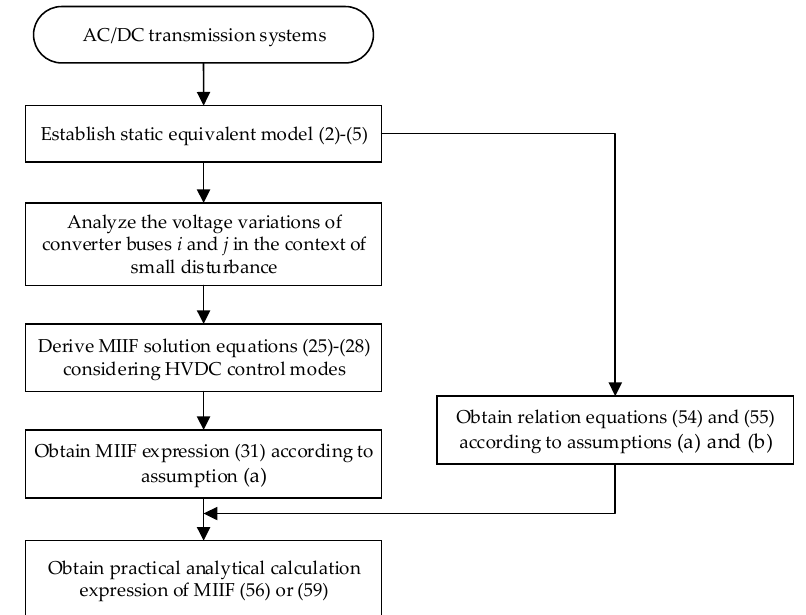
Figure 5. Flow chart of the overall process of the proposed method.